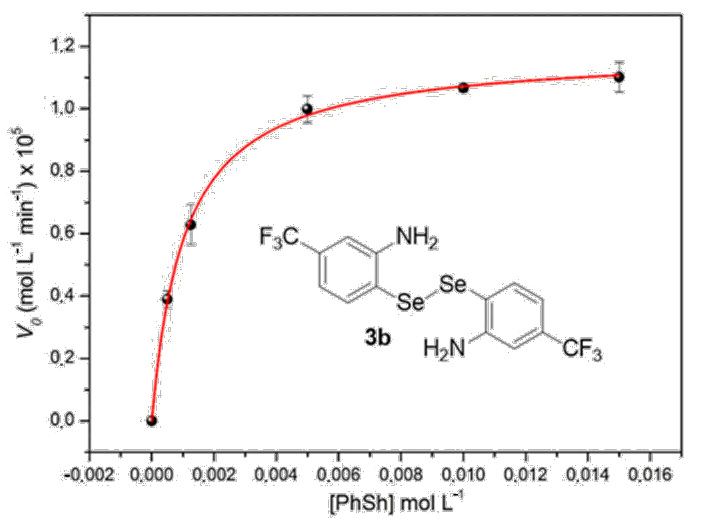
Figure 3. Initial rate ( V 0 ) plotted against substrate concentration. The initial rates were calculated from at least two experiments for each concentration of PhSH. The concentrations of 3b and H 2 O 2 were fixed at 1 × 10 − 5 and 15 × 10 − 3 mol L − 1 , respectively. The red line represents the Michaelis–Menten fit.